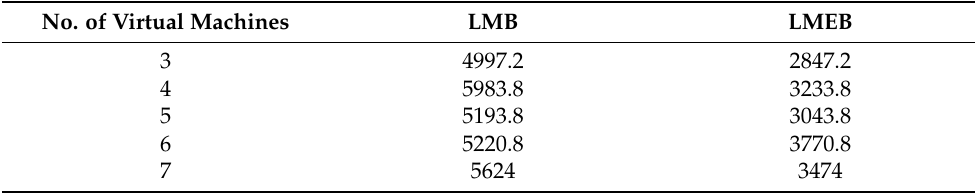
Table 8. Energy consumption for all scenarios in kWh.